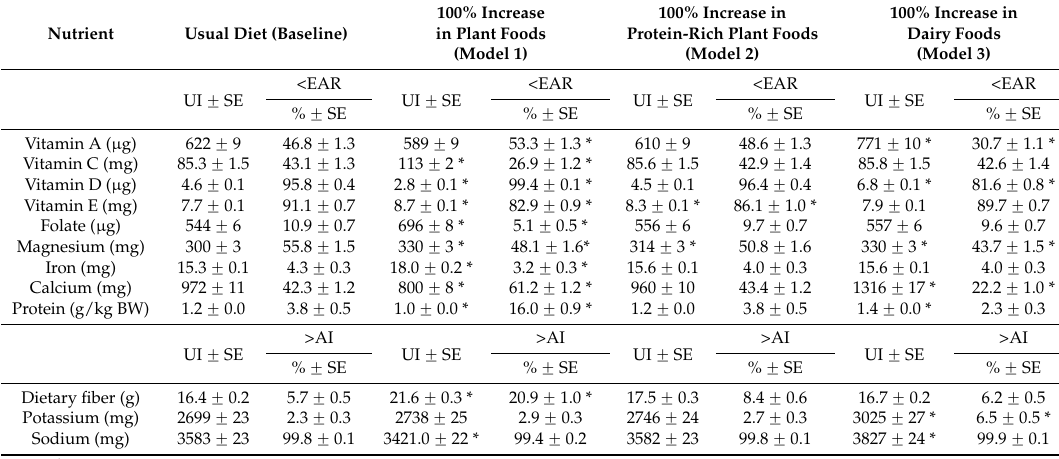
Table 6. Percentage of adults (19+ years) from NHANES 2007–2010 with nutrient intakes below the EAR or above the AI based on usual intake, 100% increase in plant foods, 100% increase in protein-rich plant foods, and 100% increase in dairy foods 1